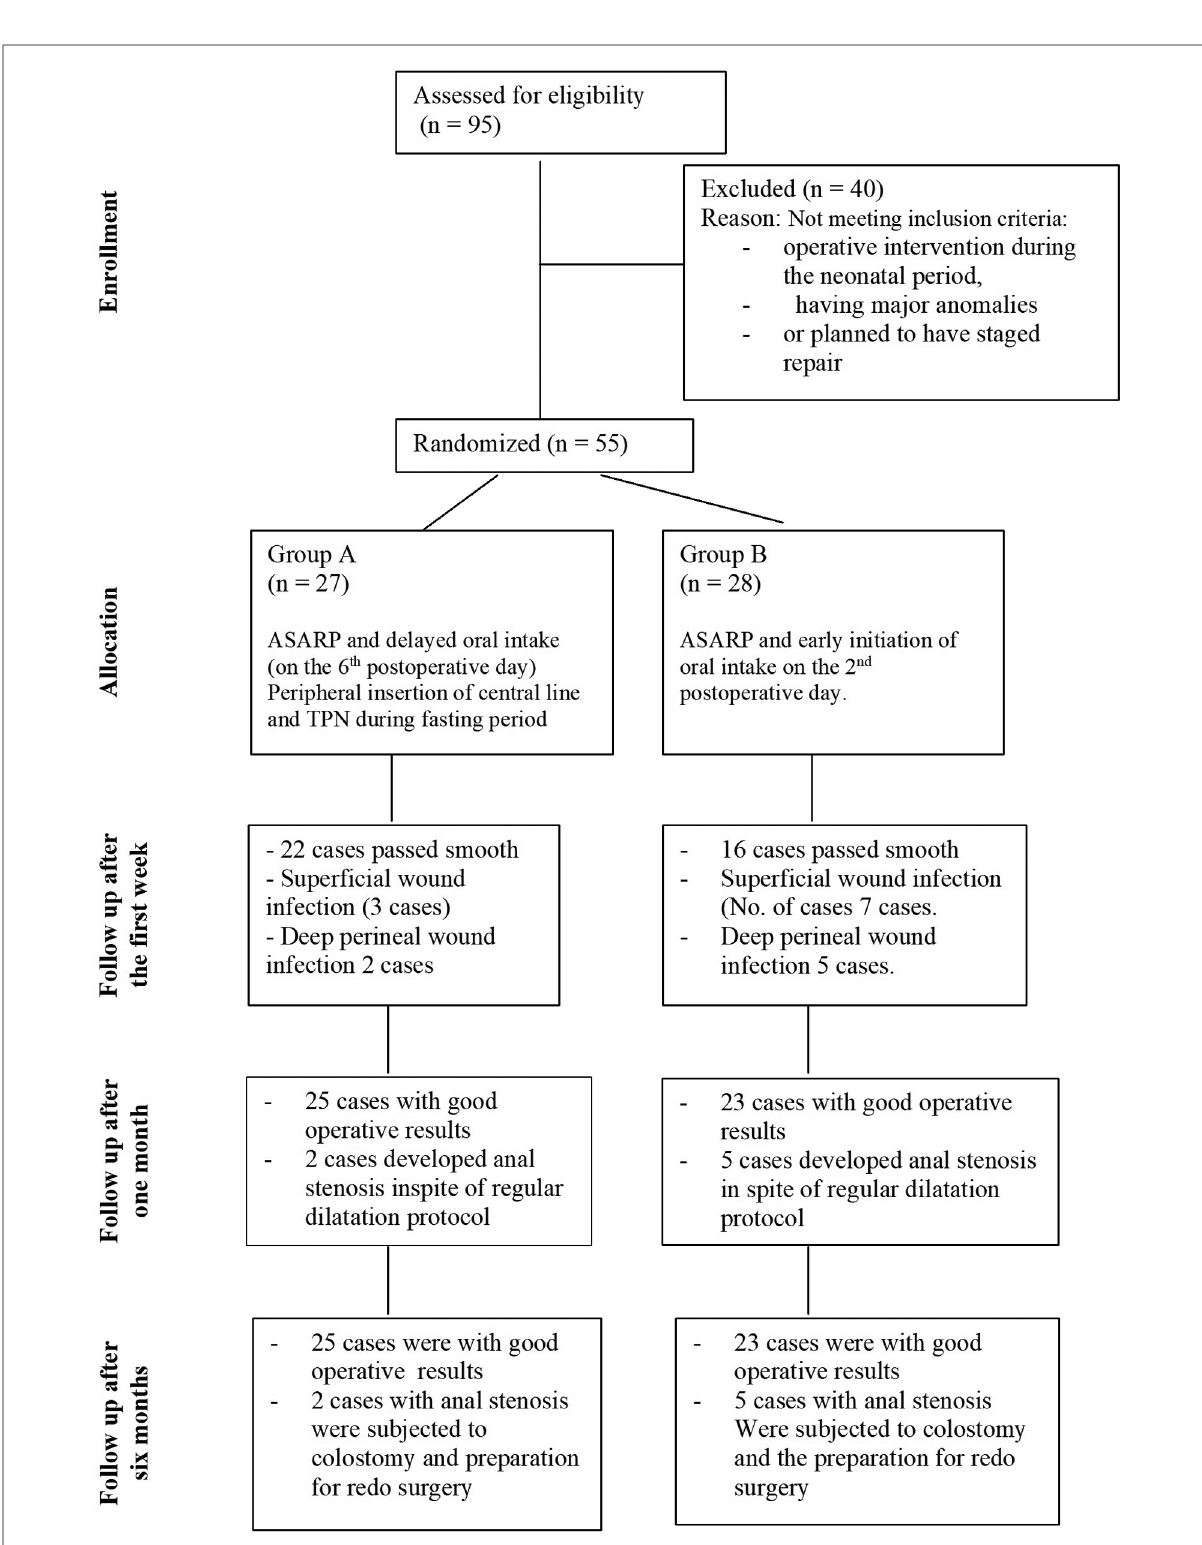
FIGURE 1 COSORT diagram shoeing the fl ow of the participants through every stage of the randomized trial inclusion and exclusion criteria of the patients and patients fl ow chart during the